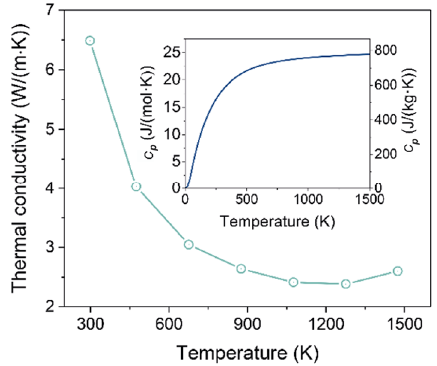
Fig. 10 Temperature dependence of thermal conductivity and heat capacity in Zn 2 SiO 4 . The inset shows the heat capacity at constant pressure, which is calculated by DFT in this